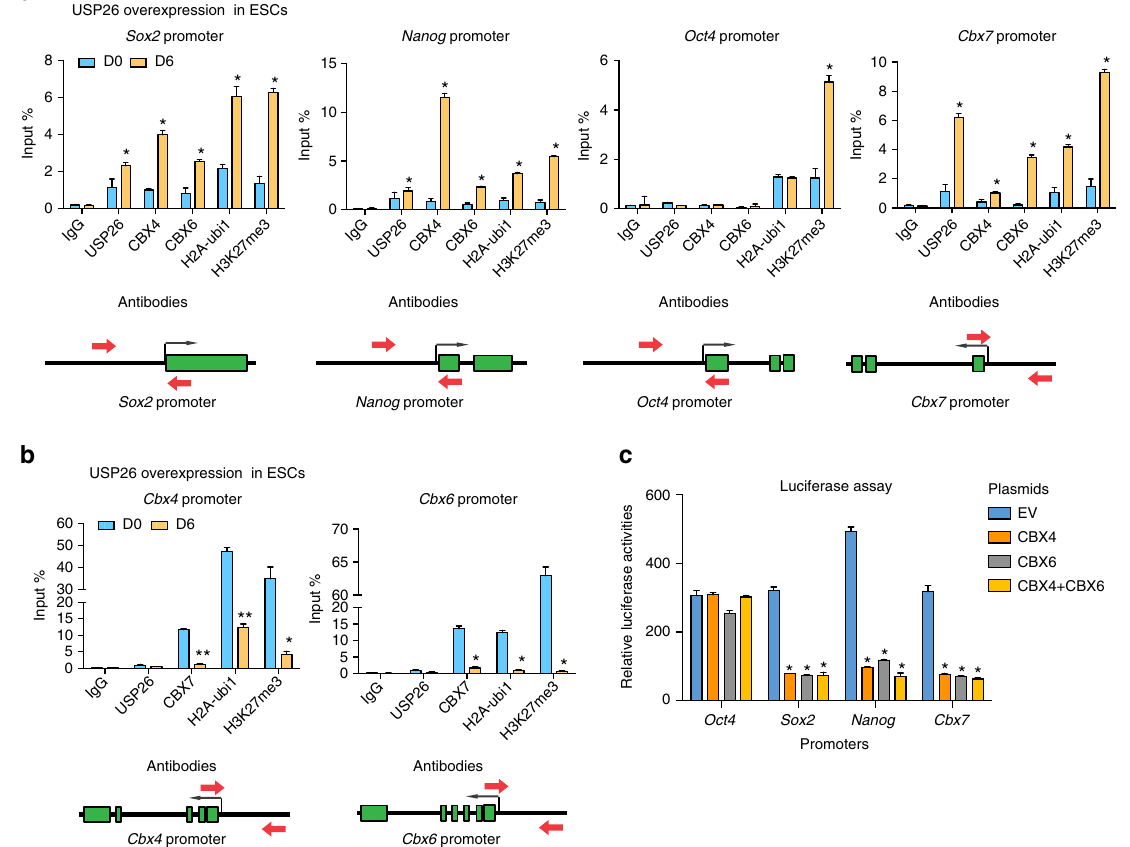
Fig. 6 CBX4 and CBX6 proteins bind to pluripotency gene promoters and inhibit their expression. a ChIP – PCR analysis of Sox2 , Nanog , Oct4 , and Cbx7 promoters in ESCs transduced with m Usp26 , * p < 0.5 compared to day 0. b ChIP – PCR analysis of Cbx4 and Cbx6 promoters in ESCs transduced with m Usp26 , * p < 0.5, ** p < 0.01 compared to day 0. c Luciferase assay of Oct4 , Sox2 , Nanog , and Cbx7 promoters with EV, Cbx4 , Cbx6 , or Cbx4 , and Cbx6 co-transfection, * p < 0.5 compared to EV. Red arrows indicate ChIP – PCR targets and black arrows indicate transcription start sites (TSSs) at the speci fi c gene promoters. The data are presented as means ± SD from three independent experiments. a , b Unpaired two-tailed Student ’ s t -test. c Two-way